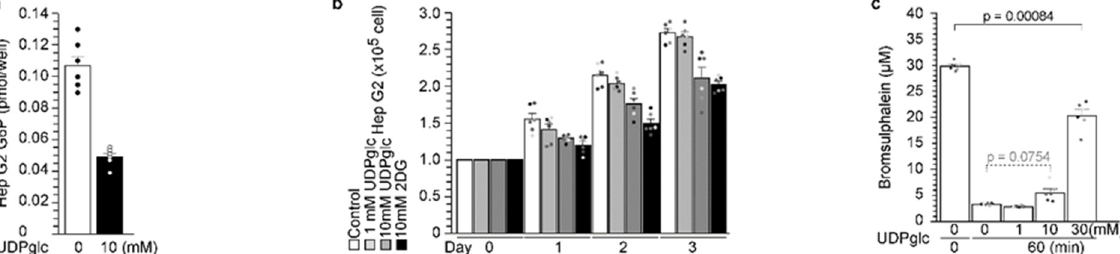
Figure 6. UDP-glucose reduced G6P production in hepatocytes. ( a ) UDP-glucose administration reduced the intracellular glucose-6-phosphate (G6P) concentration in Hep G2 cells. ( b ) UDP-glucose administration reduced the proliferation of Hep G2. ( c ) UDP-glucose administration did not change hepatocyte function. The values are reported as the means ± standard error (n = 6) with six individual data points ( a - c ).